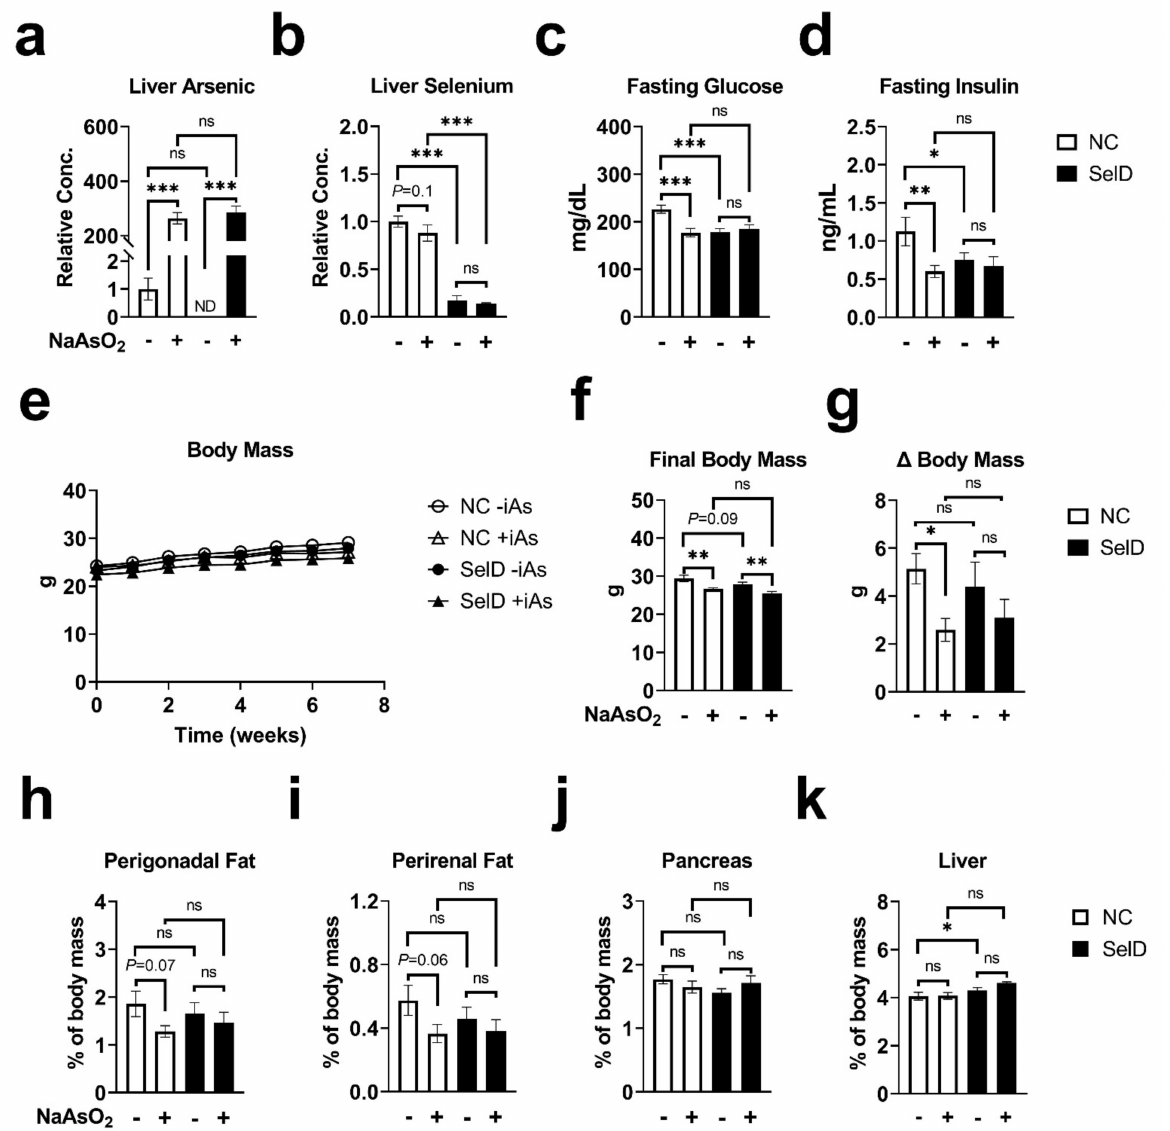
Figure 1. Effects of arsenic exposure and/or selenium deficiency on metabolic and organ mass characteristics. ( a ) Liver arsenic concentration normalized to controls ( n = 4–14); ( b ) liver selenium concentration normalized to controls ( n = 4–14); ( c ) fasting blood glucose ( n = 11–14); ( d ) fasting plasma insulin ( n = 10–12); Weekly body mass ( n = 11–15); ( f ) final body mass ( n = 10–13); ( g ) change in body mass ( n = 10–13); ( h ) perigonadal fat mass ( n = 11–14); ( i ) perirenal fat mass ( n = 11–14); ( j ) pancreas mass ( n = 10–14); ( k ) liver mass ( n = 10–14). Data were combined from three independent cohorts. Statistics: All data were log-transformed for statistical analysis. ( a – d , f – k ) ANCOVA was performed to test for main effects and interactions. ( e ) Mixed-model ANOVA was used to test overall differences in body mass between groups. * p < 0.05, ** p < 0.01, *** p < 0.001, ns = not